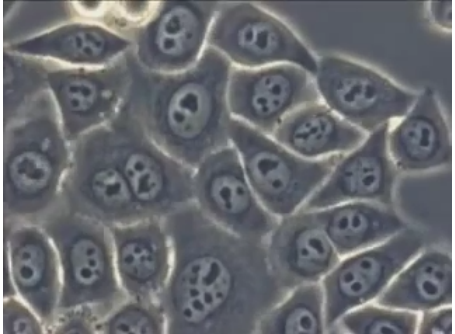
Fig. 9. Experiment 3 (Cluster formation). We compare the simulation results of Experiment 3, and in particular the morphology of the resulting cells, with in vitro culture of the HeLa cancer cells studied in [26]. (a): The single frame from the video in [26] from which HeLa cells were “extracted”. (b): The fit between the HeLa cells from (a) and our numerical simulations from Figure 8 (g). The comparison follows after properly rotating and scaling the HeLa cells and superimposing them on the simulation results.